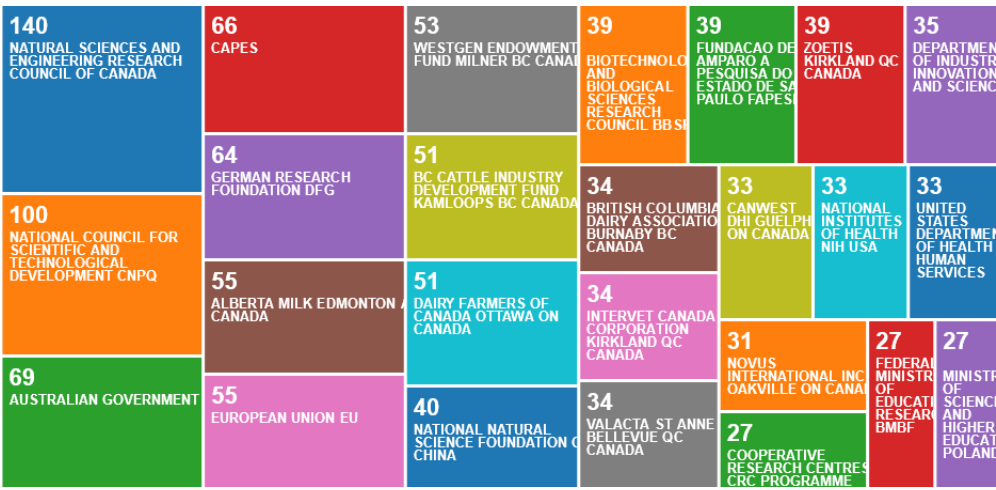
Figure 3. Number of publications per funding source, according to an online survey of publications by animal welfare centres in the Web of Science, May 2020.